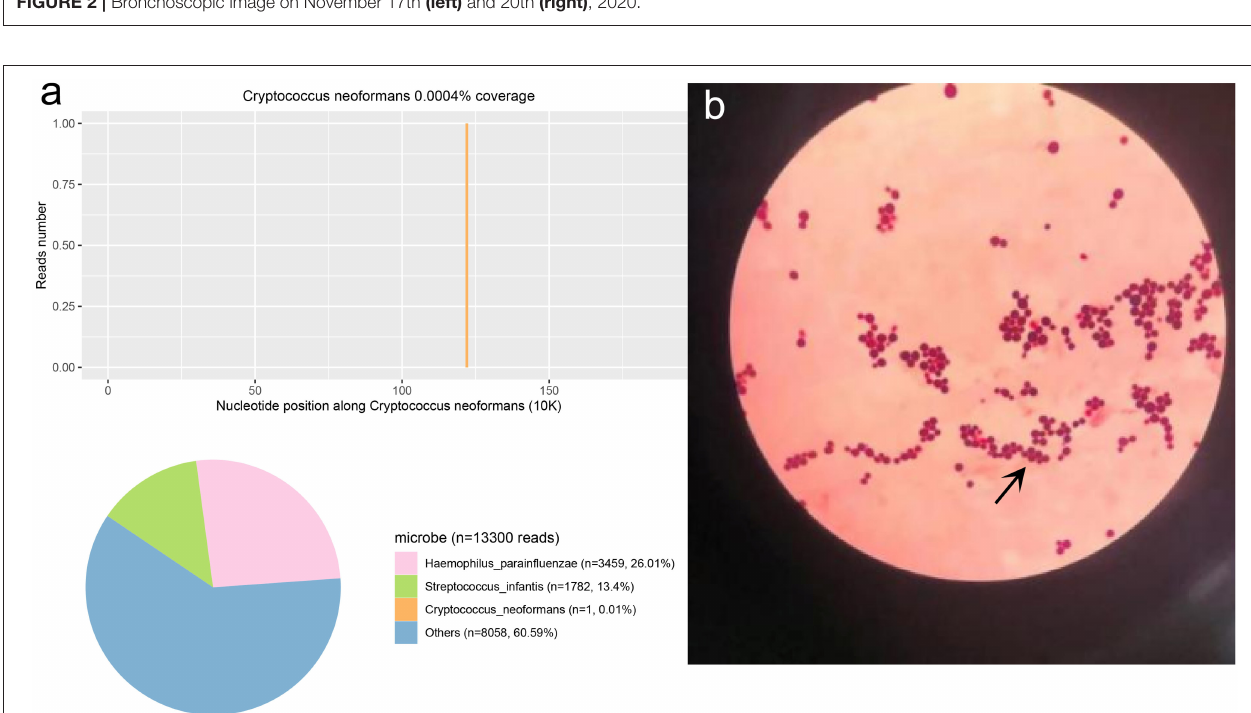
FIGURE 3 | The Cryptococcus neoformans mNGS and culture result. (a) The mNGS result of C. neoformans . 0.01% of bacterial reads corresponded to C. neoformans with a coverage of 0.0004%. (b) The results of the fungi smear showed C. neoformans .